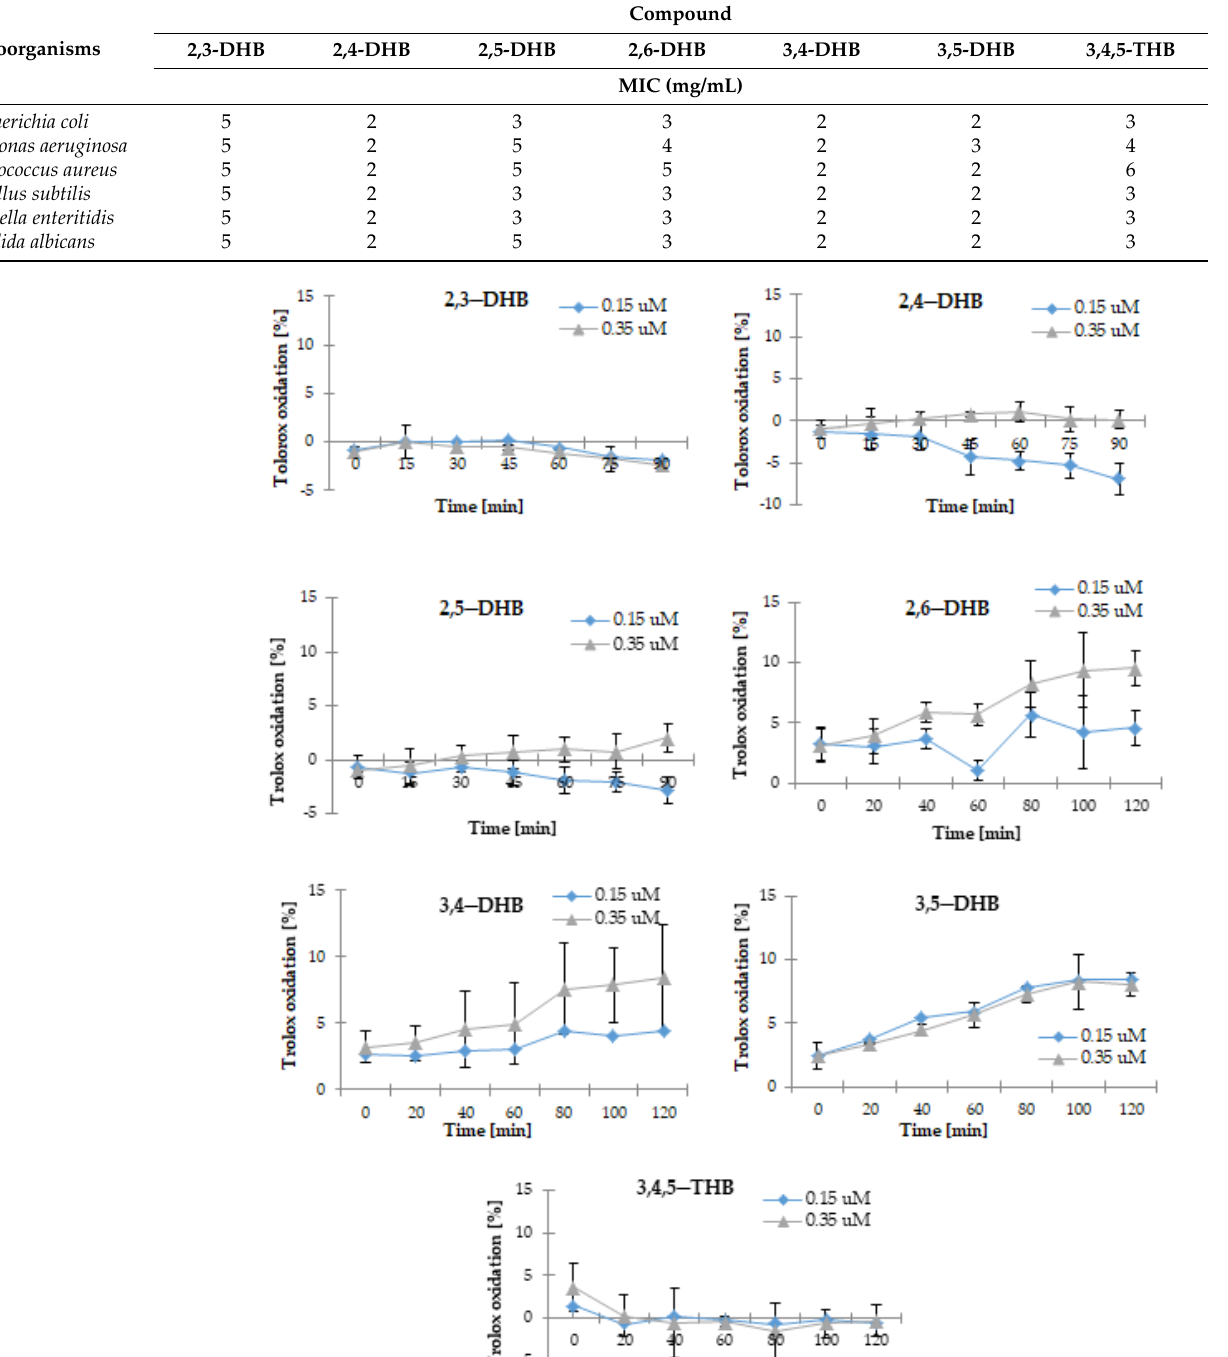
Table 4. The minimum inhibitory concentration (MIC) values (mg/mL) for the tested hydroxybenzoic acids against selected microorganisms.